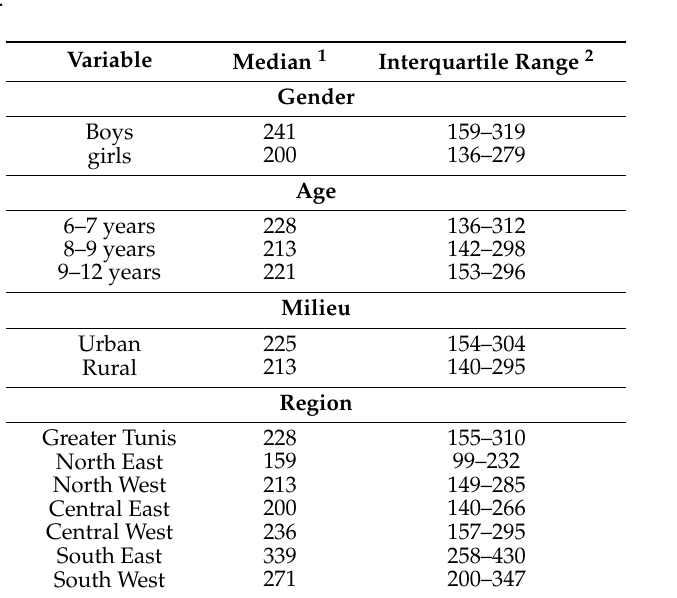
Table 2. Urinary iodine concentration of Tunisian school children aged 6–12 years, by gender, age, milieu, and